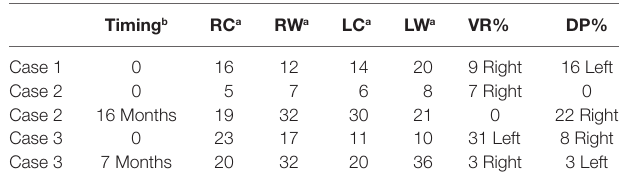
taBle 1 | Caloric vestibular test results of each